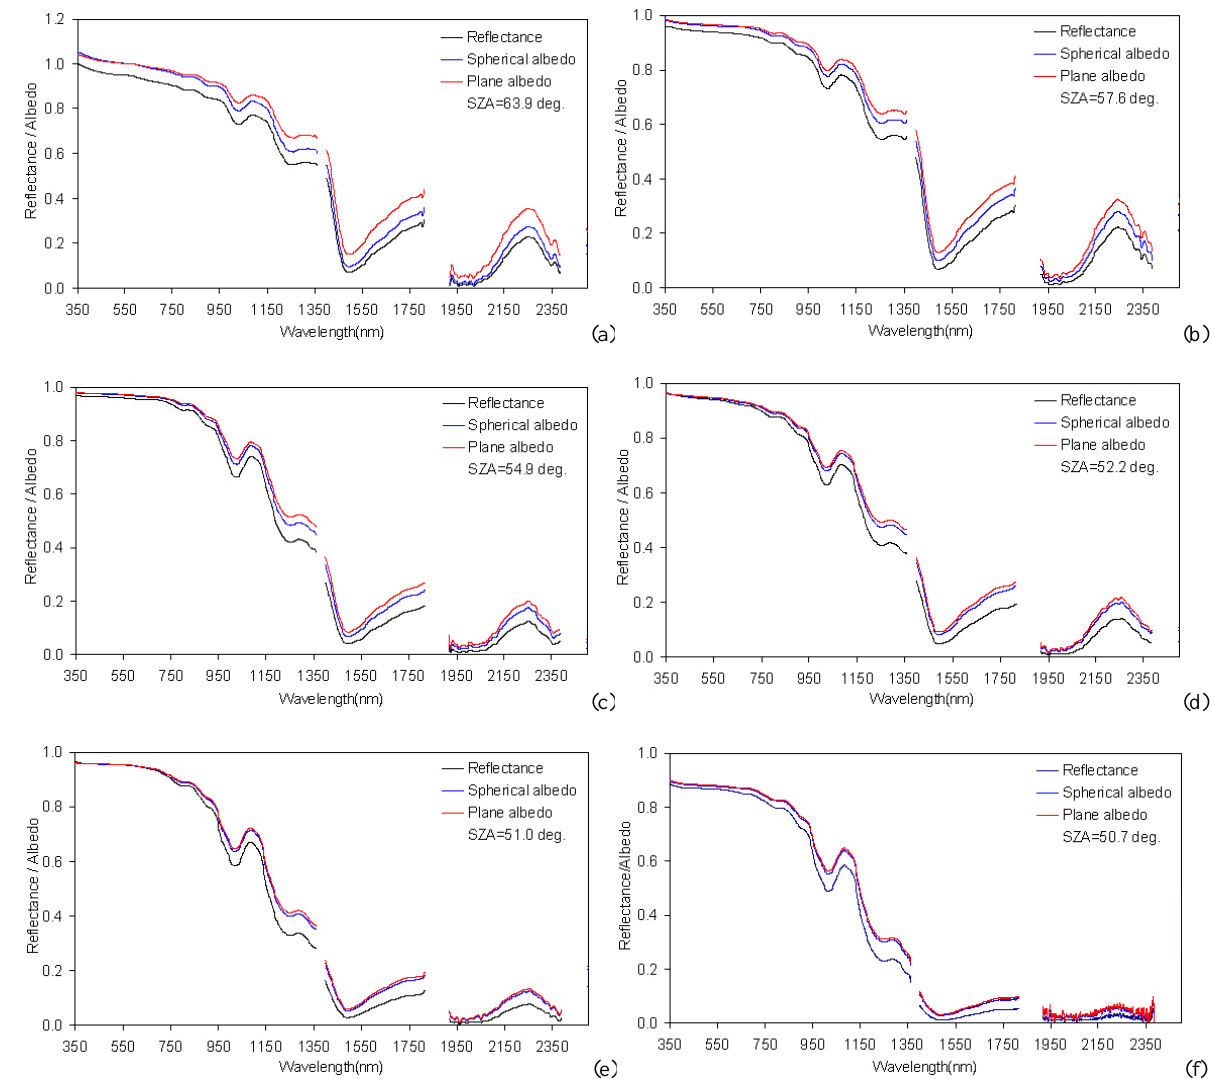
Fig. 3. Field measured reflectance for snow Type-I (new snow) and simulated spherical and plane albedo; (a) 09:30, (b) 10:20, (c) 10:45, (d) 11:20, (e) 11:50 and (f) 12:20 local